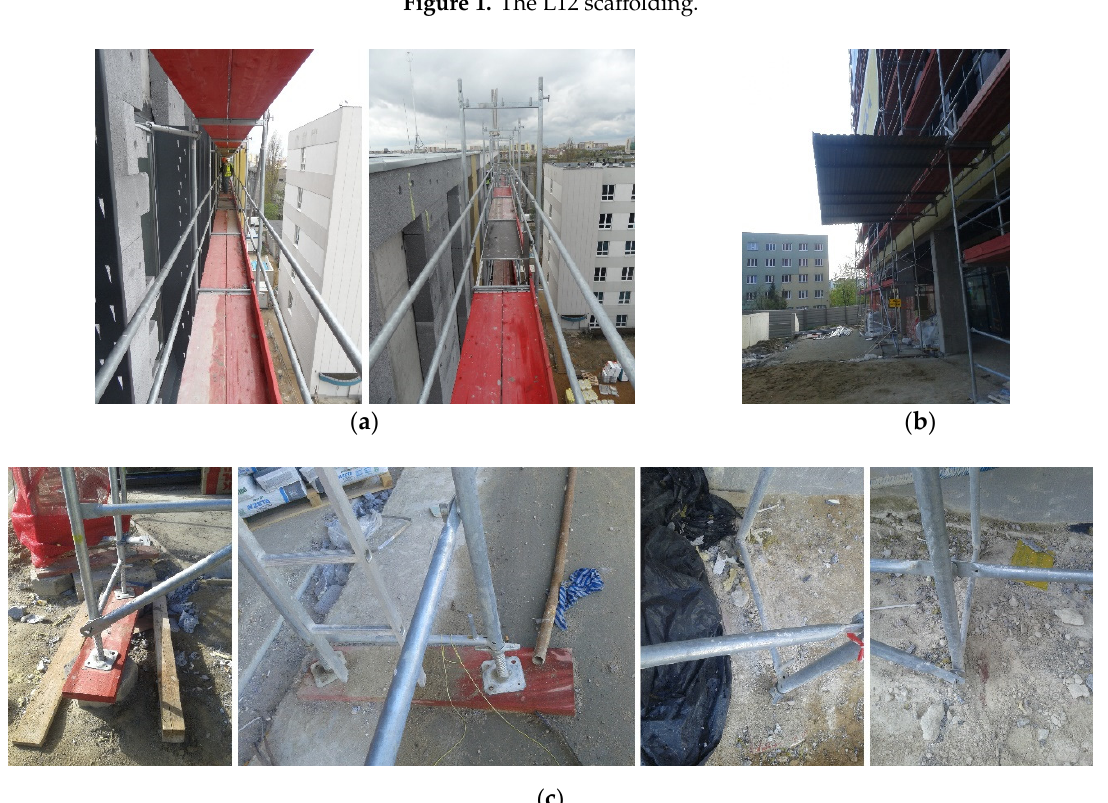
Figure 1. The L12 scaffolding.